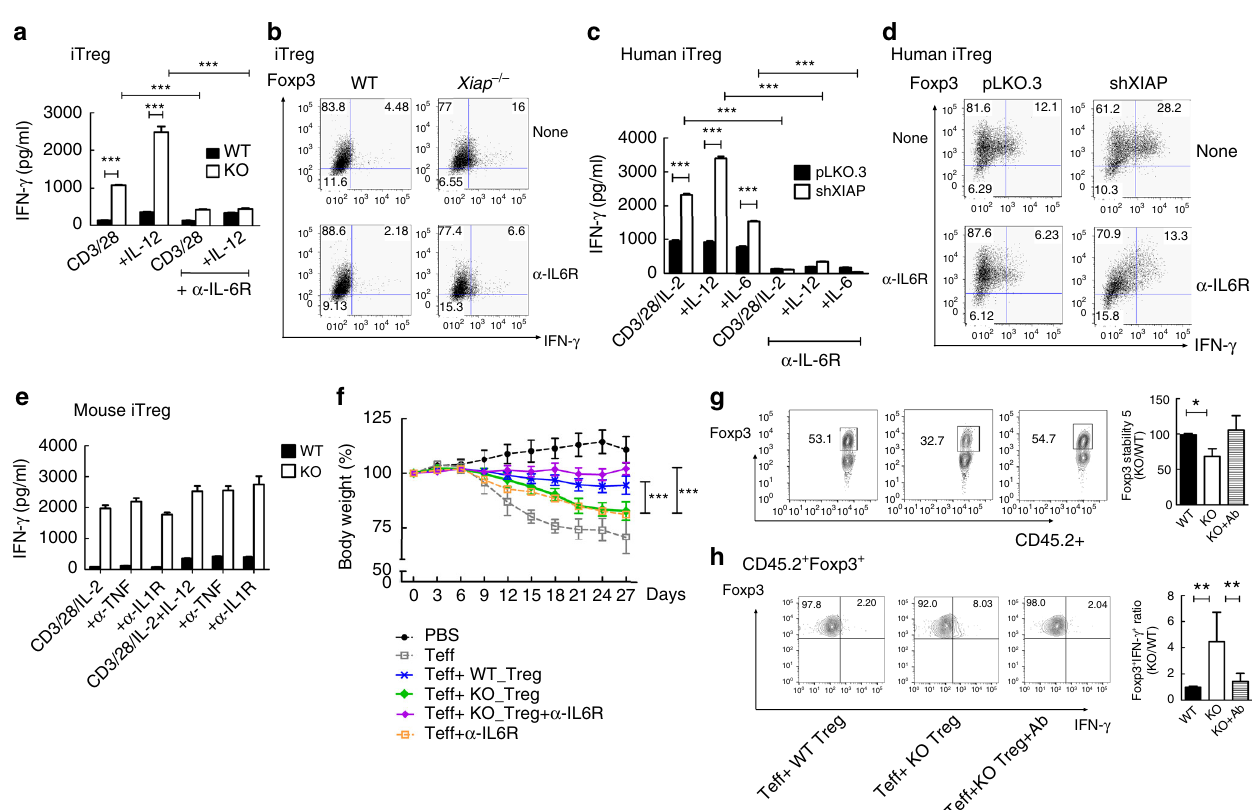
Fig. 7 Anti-IL-6R reduces the expression of IFN- γ in activated Xiap − / − Treg cells. a , b Anti-IL-6R decreases IFN- γ expression in re-stimulated Xiap − / − Treg cells. WT and Xiap − / − iTreg cells were stimulated with anti-CD3/CD28 and IL-2, or with additional IL-12 as indicated, in the absence or presence of anti-IL- 6R (50 μ g ml − 1 ) for 4 days. iTreg cells were re-stimulated with TPA/A23187 for 24 h and IFN- γ production was determined by ELISA ( a ), or reactivated with TPA/A23187 for 5 h and the expressions of Foxp3 and IFN- γ were determined by intracellular staining ( b ). c , d Anti-IL-6R inhibits IFN- γ expression in human Treg cells. Control and human XIAP-knockdown iTreg cells were stimulated as in ( a , b ), with additional IL-6 as indicated, and secretion ( c ) or intracellular expression ( d ) of IFN- γ was determined. e Inability of anti-TNF or anti-IL-1R to inhibit the production of IFN- γ in activated Xiap − / − Treg cells. WT and Xiap − / − iTreg cells were stimulated, as described in ( a ), in the presence or absence of anti-TNF or anti-IL-1R (50 μ g ml − 1 each) for 4 days. Treg cells were re-stimulated with TPA/A23187 for 24 h and the secreted IFN- γ was determined by ELISA. f Anti-IL-6R rescues the impaired suppressive activity of Xiap − / − tTreg cells in vivo. CD45.2 + WT or Xiap − / − tTreg cells were co-transferred with CD45.1 + CD4 + CD25 - effector T cells into male CD45.1 + RagI − / − mice. Anti-IL-6R antibody (500 μ g per mouse) was intraperitoneally administrated at day 0, followed by weekly dosing of 500 μ g. The body weights of mice were monitored at the indicated time-points. *** P < 0.001 by two-way ANOVA. g , h Anti-IL-6R restores Foxp3 stability and reduces IFN- γ expression in Xiap − / − tTreg cells transferred in vivo. Lymphocytes were isolated from spleen and mesenteric lymph nodes of mice in ( f ) and reactivated with TPA/A23187. The expressions of Foxp3 ( g ) and IFN- γ ( h ) in CD45.2 + T cells were determined by intracellular staining. Values are mean ± SD of triplicate samples in an experiment. * P < 0.05, ** P < 0.01, *** P < 0.001 for unpaired t -test ( a , c , g , h ). Experiments ( a – e ) were independently repeated three times with similar